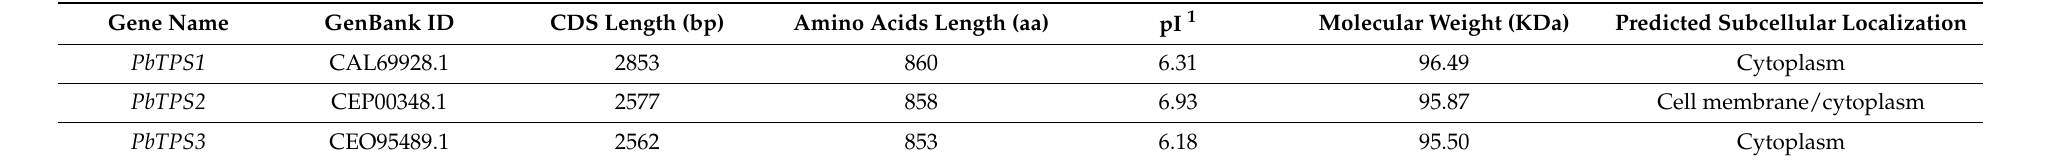
Table 2. The information of TPS genes in P brassicae